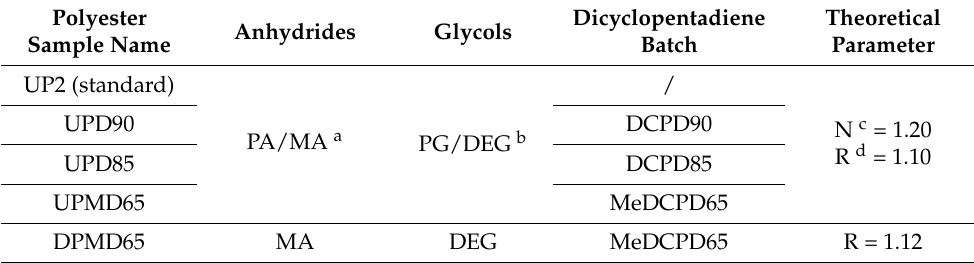
Table 3. Unsaturated polyester resins (UPRs)